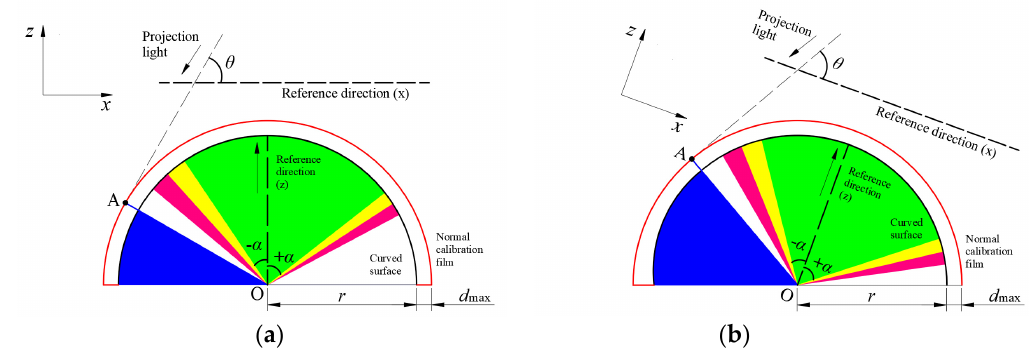
， θ = 60° utilizing ( a ) standard reference 10